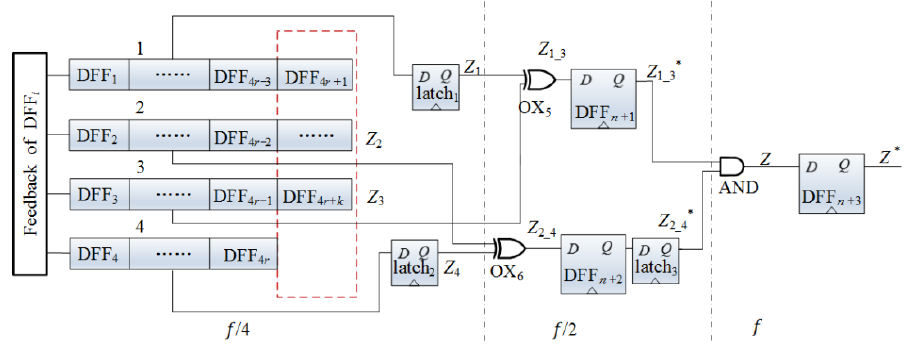
Figure 2. Proposed measurement matrix generator.